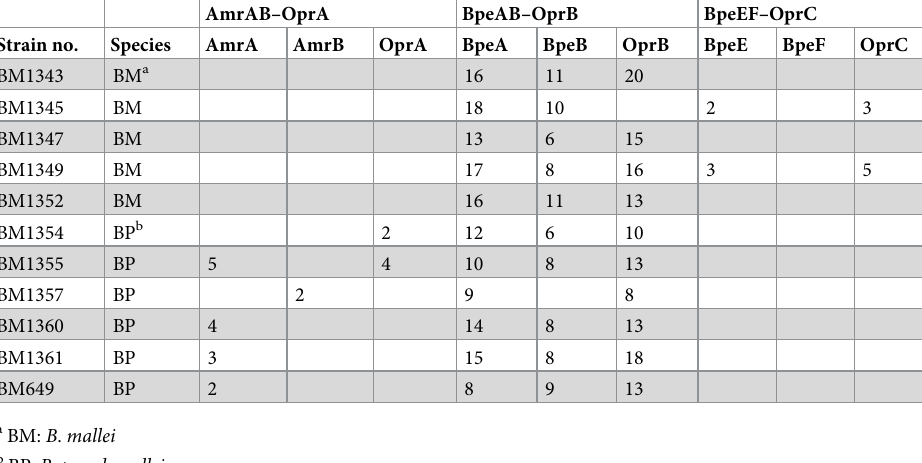
Table 8. Number of detected peptides from efflux pumps.